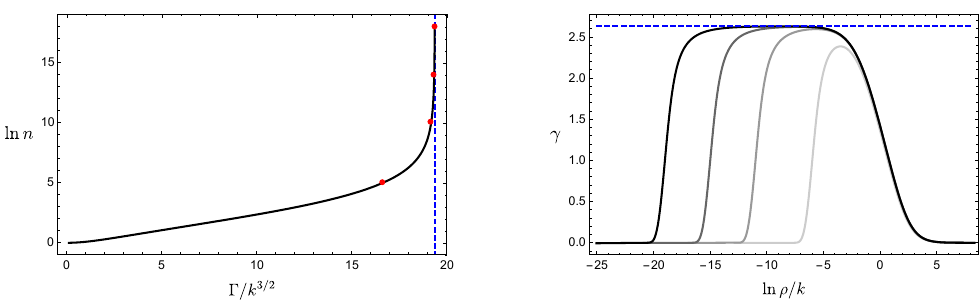
Figure 6 . Boomerang RG (cid:13)ows for m 2 = (cid:0) 15 = 4 and (cid:24) = (cid:0) 1 = 4. The left plot shows the refractive index n , de(cid:12)ned by (5.6), as a function of the deformation parameter (cid:0) =k 3 = 2 , for the one parameter family of boomerang RG (cid:13)ows that exist in the (cid:12)nite range 0 (cid:20) (cid:0) =k 3 = 2 (cid:20) (cid:22)(cid:0). For the special value (cid:0) =k 3 = 2 = (cid:22)(cid:0) (cid:24) 19 : 37 (dashed vertical line) we have the AdS 0 to AdS 2 (cid:2) R 3 RG (cid:13)ow. As (cid:0) =k 3 = 2 5 approaches (cid:22)(cid:0) there is a build up of an intermediate scaling regime, determined by the AdS 2 (cid:2) R 3 solution, as displayed by the radial behaviour of the scalar function for (cid:0) =k 3 = 2 = 16 : 65, 19 : 17, 19 : 33 and 19 : 36 (red dots on the left plot and light grey to dark grey on the right plot) and we have also marked the value of the scalar in the AdS 2 (cid:2) R 3 , (cid:13) = 48 1 = 4 , by a horizontal dashed (2)